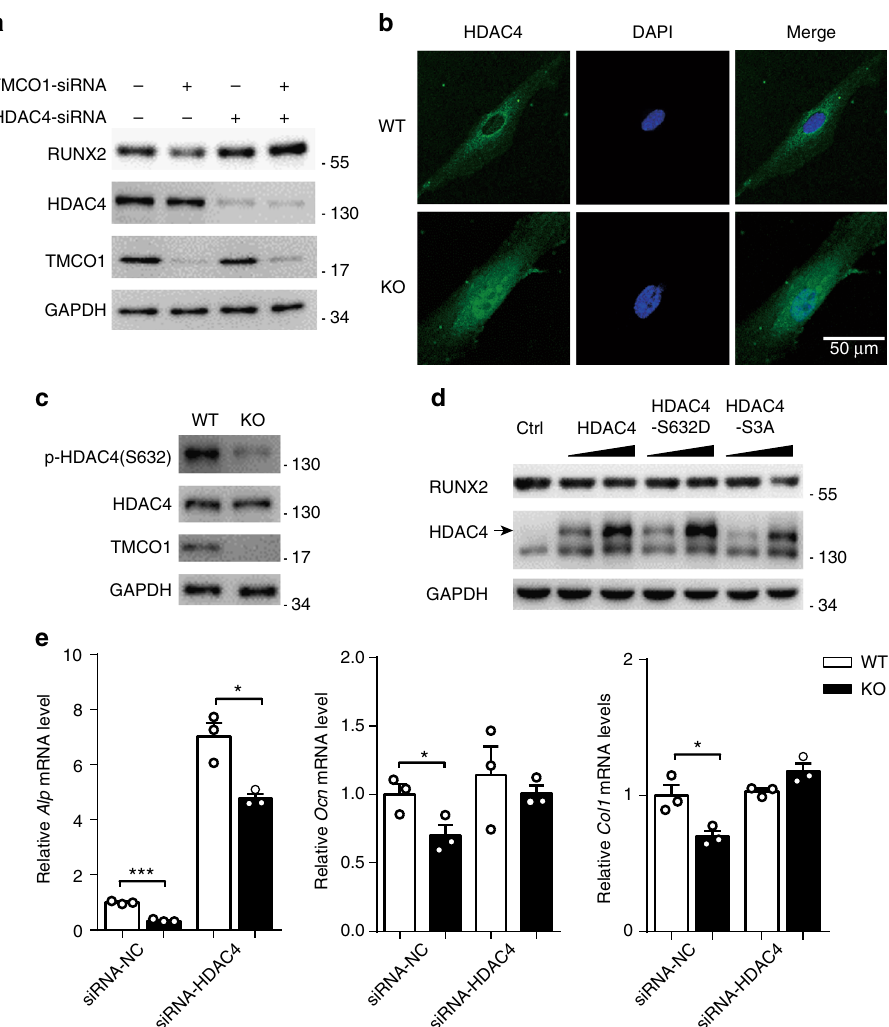
Fig. 4 TMCO1 de fi ciency leads to the nuclear accumulation of HDAC4 to downregulate RUNX2. a HDAC4 is required for the reduction of RUNX2 in TMCO1-knockdown MC3T3-E1 cells. MC3T3-E1 cells were transfected with HDAC4-siRNA and/or TMCO1-siRNA. After 36 h, RUNX2 expression was analyzed by western blotting. Representative results of three independent experiments are shown. b Lack of TMCO1 promotes HDAC4 nuclear translocation in vitro. Primary osteoblasts from the calvarium in WT and Tmco1 − / − newborns were stained with an anti-HDAC4 antibody and Hoechst, followed by confocal fl uorescence microscopy. Scale bars, 50 μ m. Immuno fl uorescence assay was repeated by two independent experiments. c Western blot analysis of HDAC4 phosphorylation in WT and Tmco1 − / − osteoblasts. Representative results of three independent experiments are shown. d Effect of HDAC4 overexpression on RUNX2 protein levels in MC3T3-E1 cells. MC3T3-E1 cells were transfected with increasing amounts of HDAC4, cytoplasm- localized HDAC4-S632D, or nucleus-localized HDAC4-S3A. After 36 h, the expression of RUNX2 was analyzed by western blotting. Representative results of three independent experiments are shown. e Q-PCR analysis of osteoblast-speci fi c genes in WT and Tmco1 − / − osteoblasts treated with HDAC4-siRNA. Representative results of three independent experiments are shown. Data are presented as the mean ± s.e.m. unpaired Student ’ s t test, n = 3, * P < 0.05, ** P < 0.01, *** P <